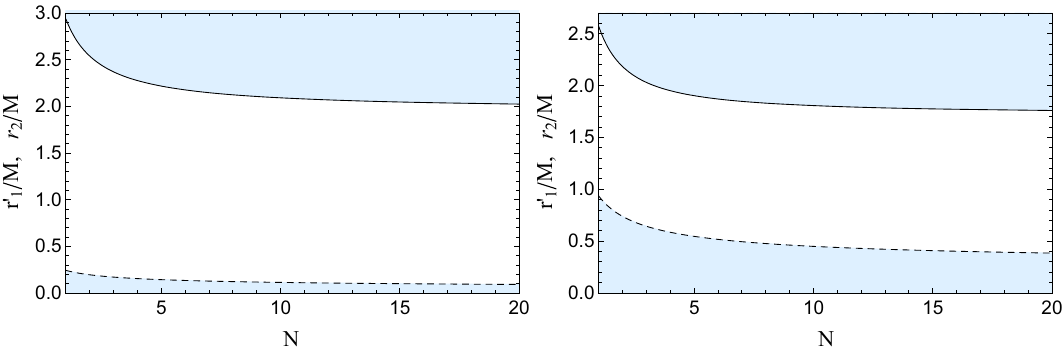
Fig. 5 DependenceoftheboundariesoftheNECintheregularrotating inner branch and inner boundary r 2 ( solid curves ) of the outer branch of black hole spacetime in conformal gravity on the degree N in the large the NEC are depicted. In the shaded region the NEC is satisfied, while conformal factor limit. In the left panel we have a / M = 0 . 3, while in in the white region the NEC is the right panel a / M = 0 . 7. Outer r (cid:10) ( dashed curves ) boundary of the 1